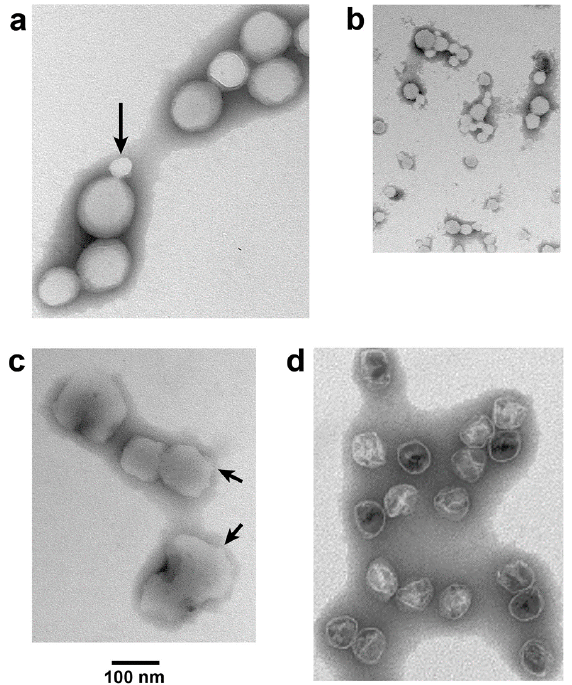
Figure 5. Response of ipDNA-capsids to ATP. Electron microscopy (EM) of ( a ) untreated, peak F = 0.30–0.41-NLD ipDNA-capsids, Nycodenz density = 1.070 g/mL; ( b ) the sample of ( a ) exposed to 3.0 mM magnesium ATP at 30 °C for 1.0 h; ( c ) the sample of ( b ) exposed to 100 mM sodium ADP at 30 °C for 1.0 h; ( d ) WT NLD capsid II. All samples were prepared for EM by negative staining. Images have equal